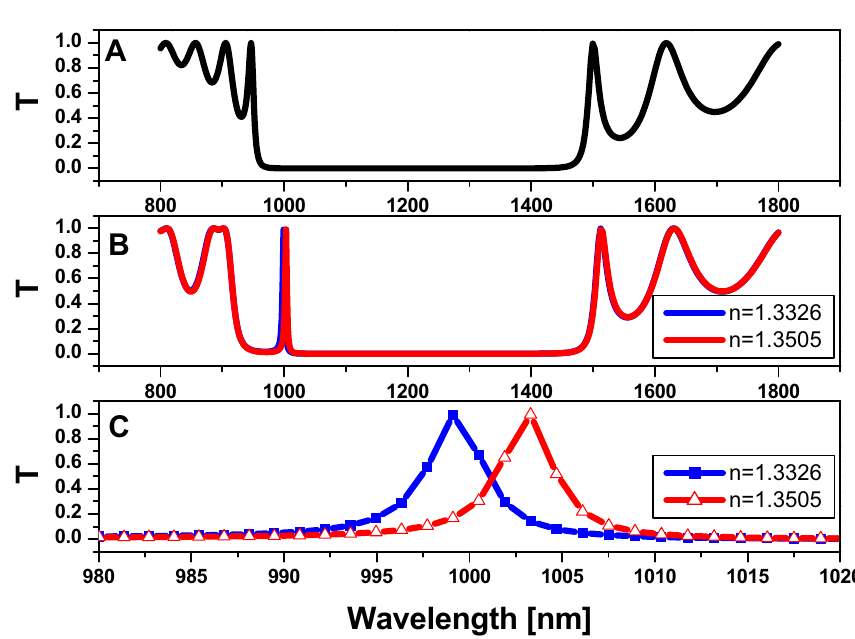
Figure 8. Transmission property of a two dimensional hexagonal cylinder unit cell with R = 180nm D = 120nm , N = 5, and the host material titanium dioxide ( TiO 2 ) . ( A ) All cylinders are filled with air; ( B ) All cylinders are filled with air except for the centered pour, which is filled with saline water with varying refractive index values; and ( C ) zoom in on the defect peak in figure ( B